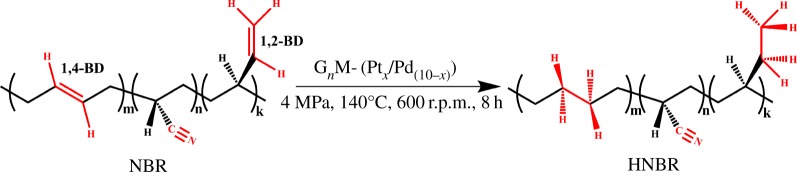
The hydrogenation of NBR catalyzed by GnM-(Ptx/Pd10−x).